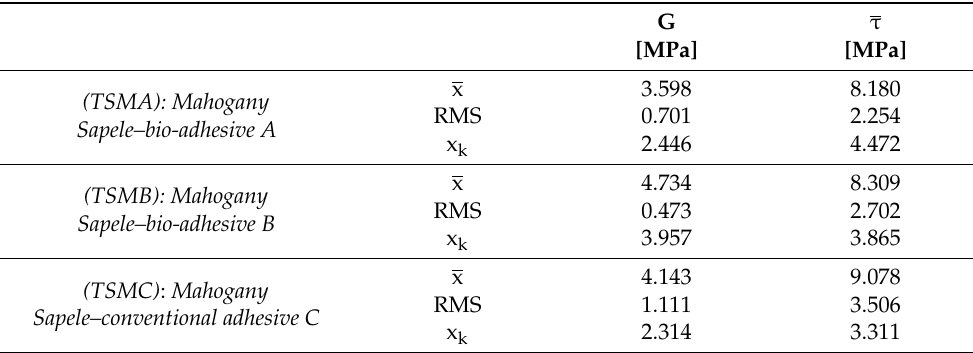
Table 7. Results for Mahogany Sapele lap joint shear properties by tensile